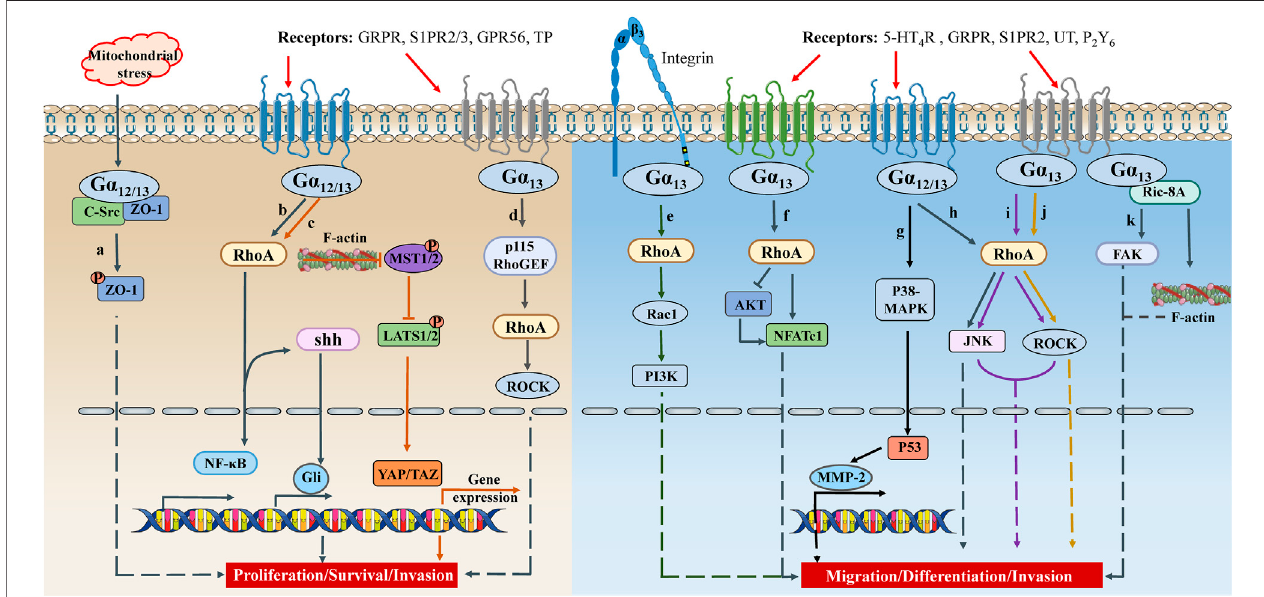
FIGURE 2 | The crosstalk between G α 12/13 signaling and cell proliferation/migration. Under different physiological/pathological environments, GPCRs on the cell membrane receive different signals, couple G α 12 or G α 13 , activate signal cascades, and promote synthesis of transcription factors or secretion of in fl ammatory factors. These signals ultimately lead to different cell activities, such as cell proliferation, survival, differentiation, migration, invasion, etc. TP, thromboxane A2 receptor; UT, urotensin II receptor; P 2 Y 6 , purinergic receptor 6; shh, sonic hedgehog; MST1/2, mammalian sterile 20-like kinases